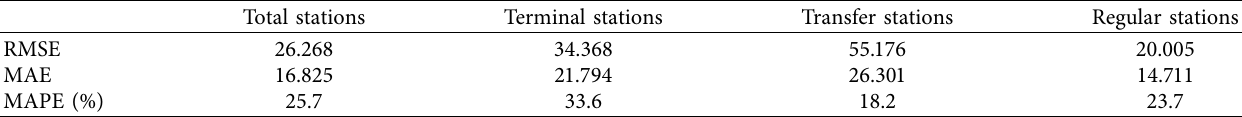
Table 4: Performance of the proposed HSTDL-net for outbound passenger